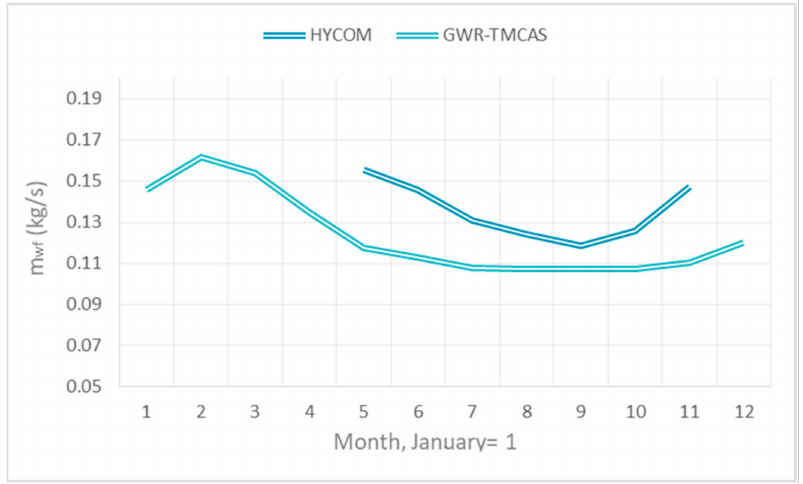
Figure 5. Working fluid mass flow along the year for OTEC-CC-MX-1 kWe obtained using HYCOM and GWR-TMCAS temperature